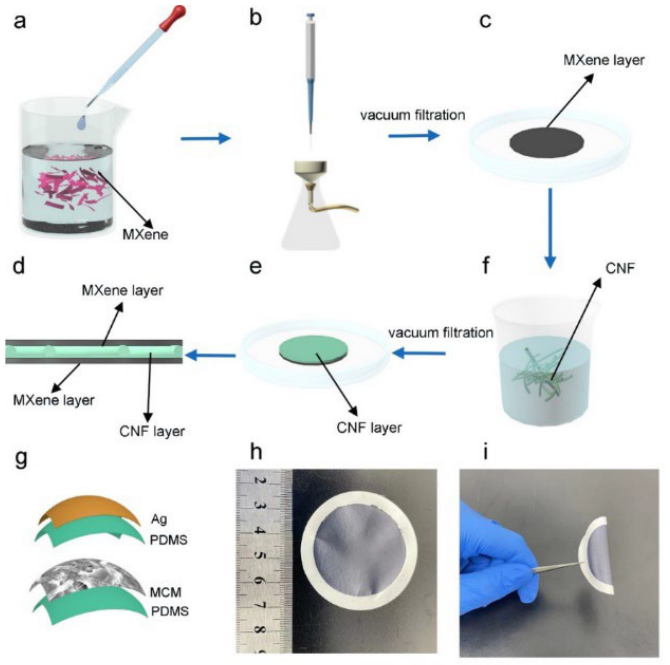
Figure 1. Schematic illustration of a multi-layer MXene composite film and a MXene-based TENG. ( a ) The few-layer MXene solution. ( b ) The self-assembled process via vacuum filtration. ( c ) The MXene thin film. ( d ) The CNF solution. ( e ) A CNF layer was formed on the MXene film. ( f ) The MCM multilayer. ( g ) Schematic structure of the MCM-TENG. ( h ) Photograph of the MCM composite electrode. ( i ) High flexibility of the flexible